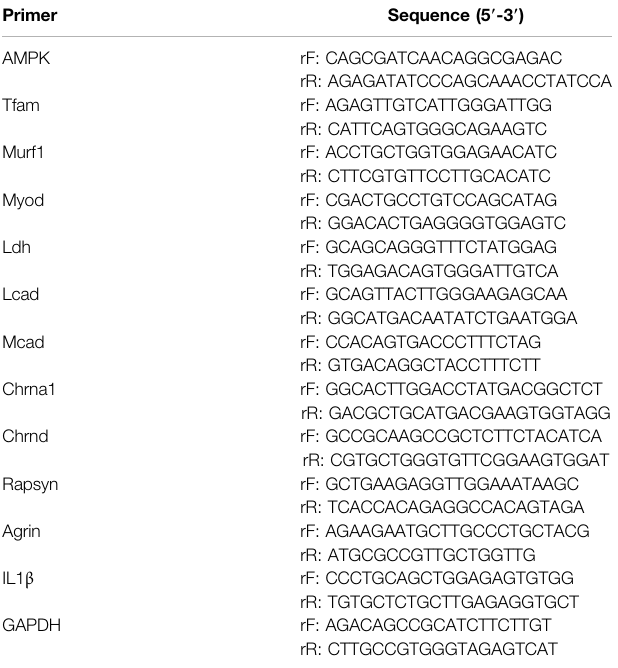
TABLE 1 | Sequences of all